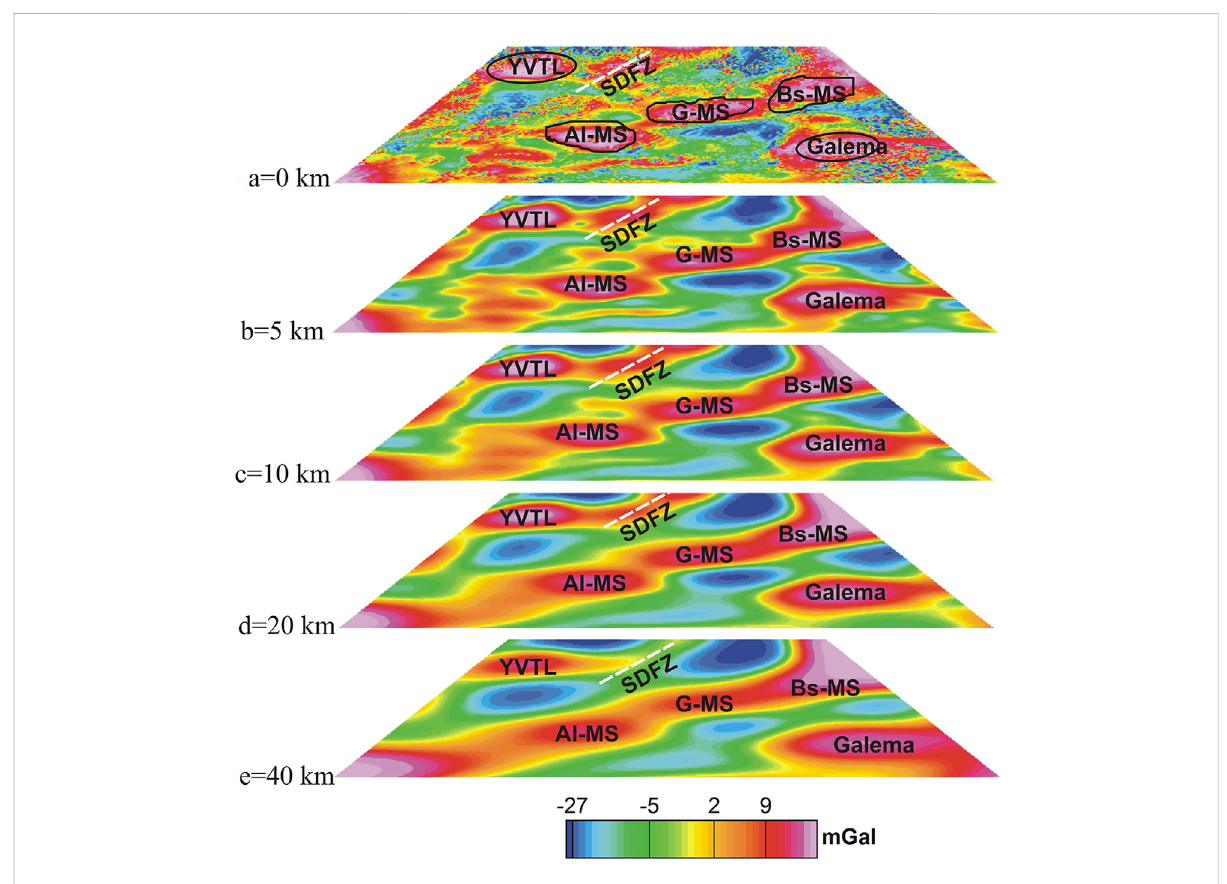
FIGURE 8 Upward continuation of the residual gravity anomaly map (Figure 8) to heights of (A) 0 km, (B) 5 km, (C) 10 km, (D) 20 km, and (E) 30